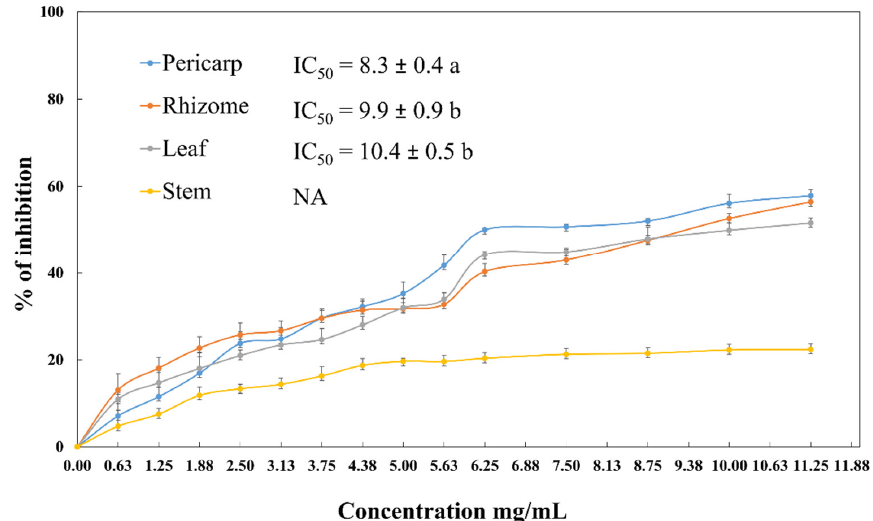
Figure 5. Pancreatic lipase inhibitory activity of leaf, stem, pericarp and rhizome ethanolic extracts of A. acutifolius . The pancreatic lipase inhibitory activity was expressed as IC 50 μg/mL of dry weight. Results correspond to the mean ± standard deviation of three replicates IC 50 values followed by different letters are statistically different. NA: no activity.